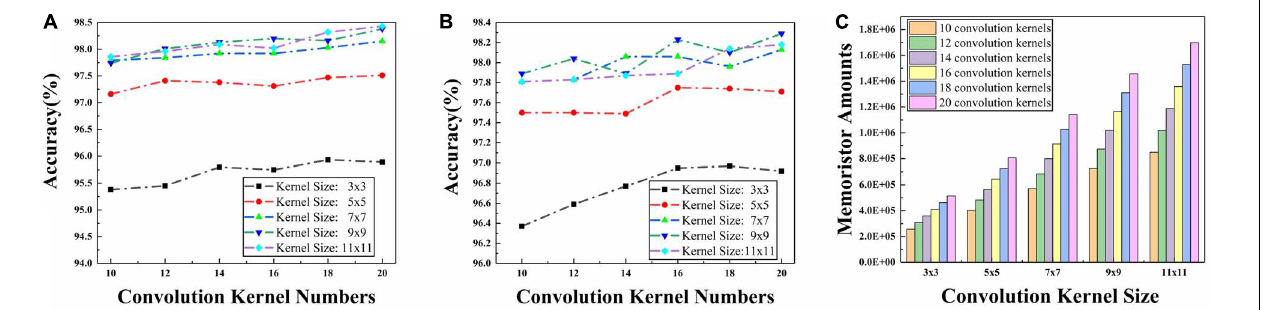
FIGURE 7 | Simulation results about convolution kernel size and amounts impact on network performance and number of memristors that required in hardware implementation of the CFB-CNN architecture, (A) simulation results for ± 1 MD, (B) simulations results 01 MD, (C) memristor amounts required in hardware implementation of the CFB-CNN